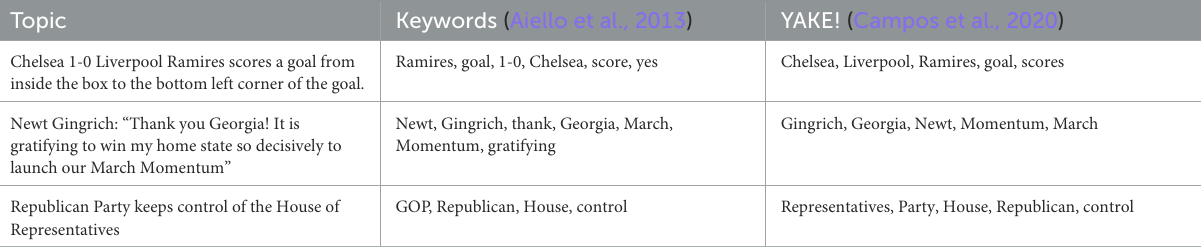
TABLE 10 Keyphrase extraction can replace manual annotation in keyword evaluations. Topic Keywords (Aiello et al.,